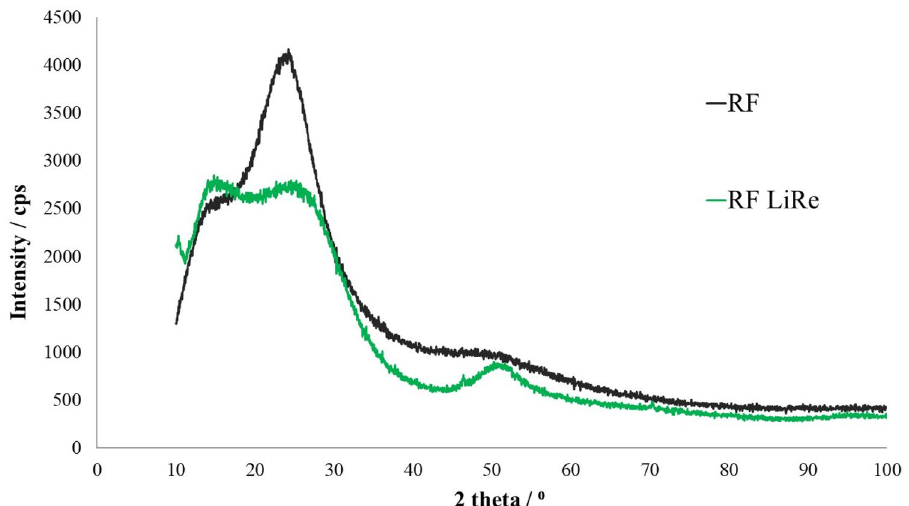
Fig. 4 The X-ray powder diffraction patterns for gels prepared with sodium carbon- ate (RF) and lithium perrhenate (RF LiRe) catalysts